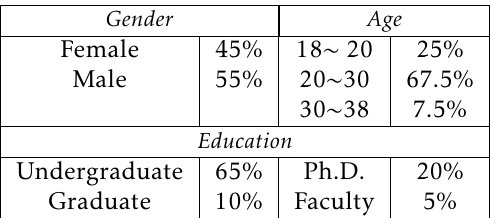
Table 1. Participants Basic Information